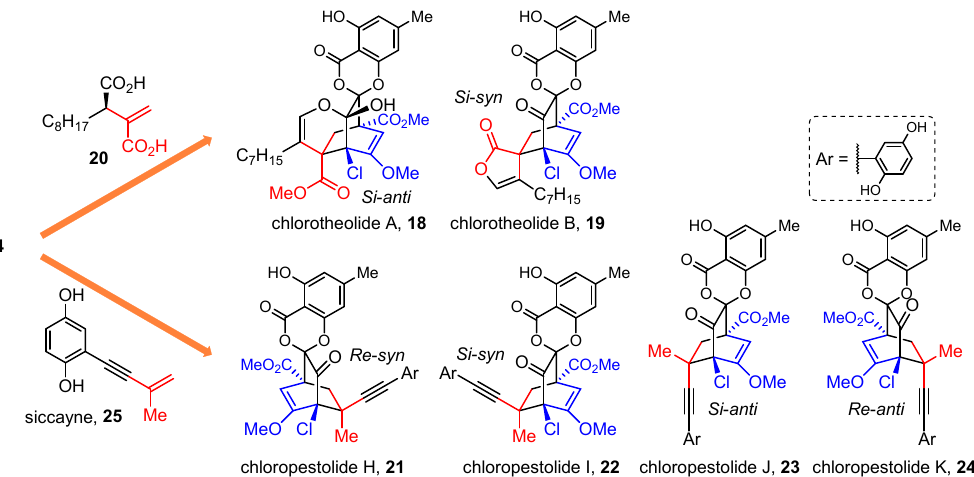
Scheme 2. Natural products derived by the intermolecular Diels–Alder reaction of maldoxin.